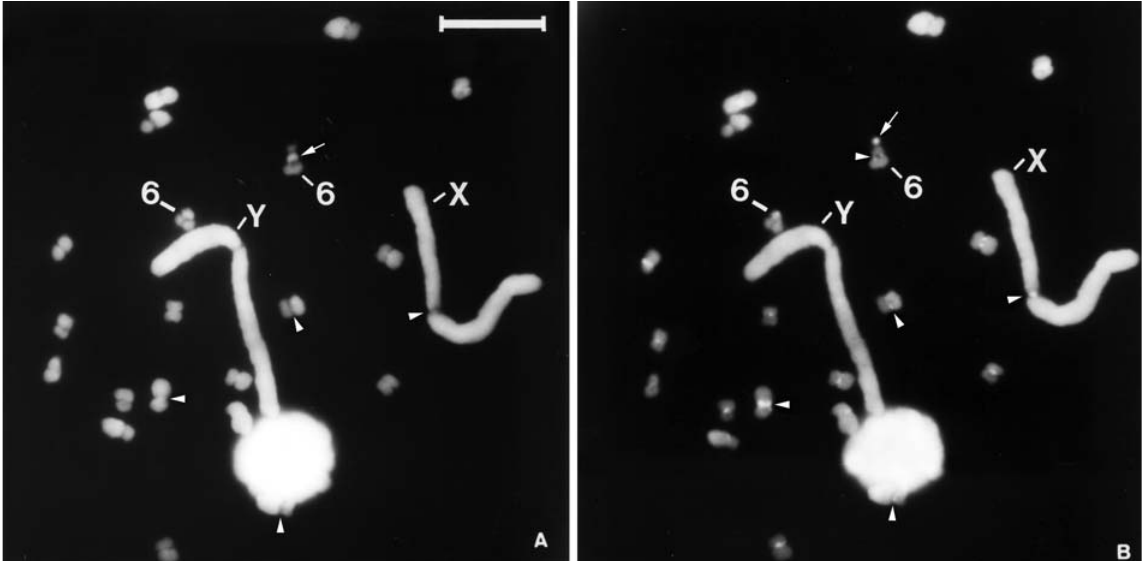
Figure 5 - Male Paranaita opima embryo mitotic metaphase stained with CMA 3 , DA and DAPI and showing 2n = 22 (20+XY). A. Chromomycin A 3 staining, showing the CMA 3 -negative centromeric region (arrowhead) of some chromosomes and the positive CMA 3 labeling at the interstitial region of the short arm of pair 6 (arrow). B. DAPI staining showing the DAPI-positive centromeric region (arrowhead) of some chromosomes, the negative DAPI interstitial region of the short arm of pair 6 and the DAPI-positive terminal region of the short arm of pair 6 (arrow). Bar = 10 (cid:2)